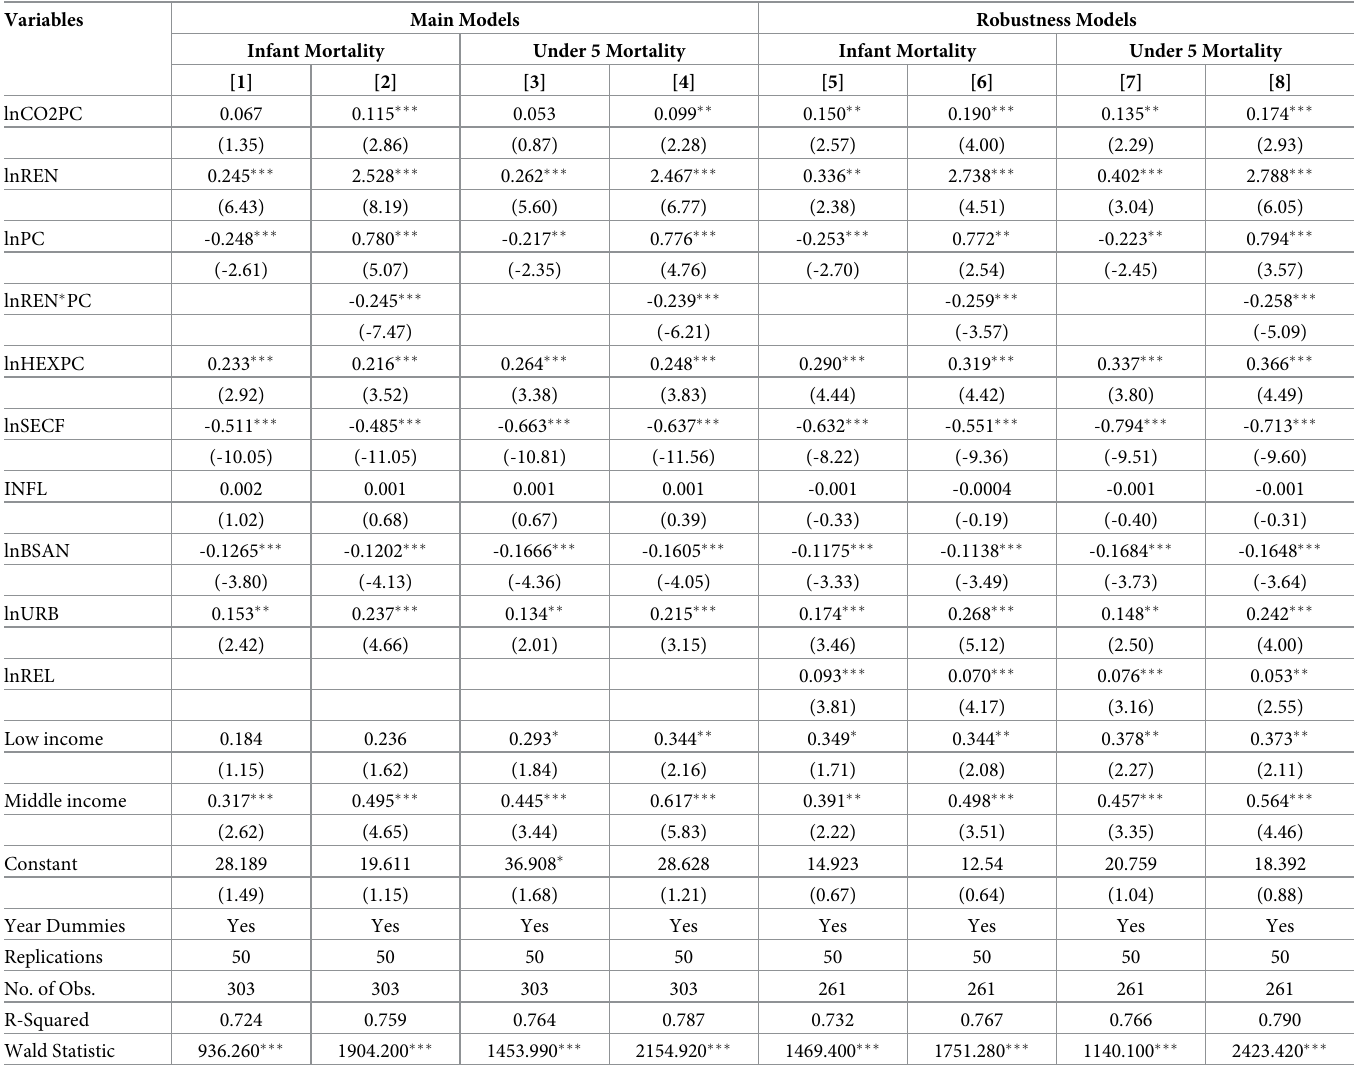
Table 4. Bootstrap least squares dummy variables results, full